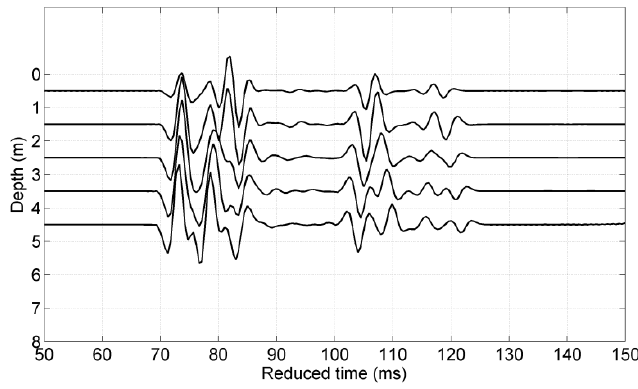
Figure 3. Modeled channel impulse response calculated by the PlaneRay program to the vertical array with five hydrophones spanning the depth of 0.5 m to 4.5 m.